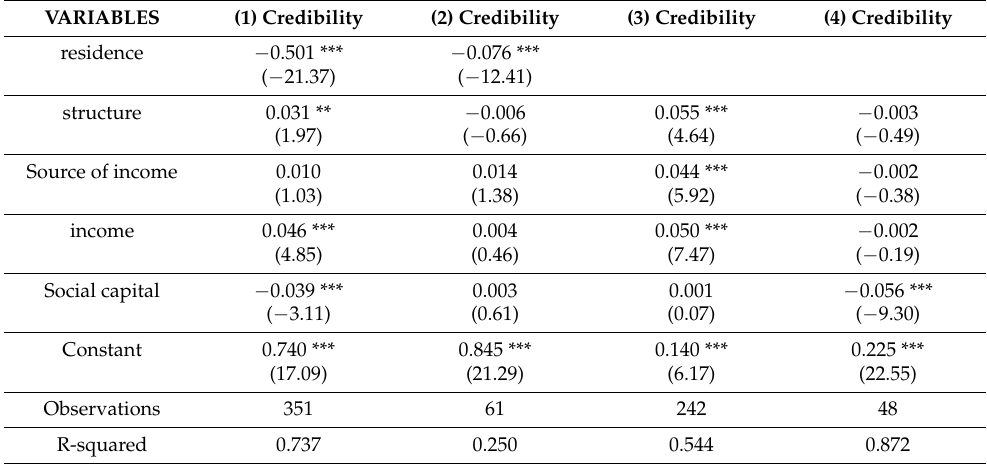
Table 8. Regression results of the credibility of the MVLT and the individual characteristics of farmers.